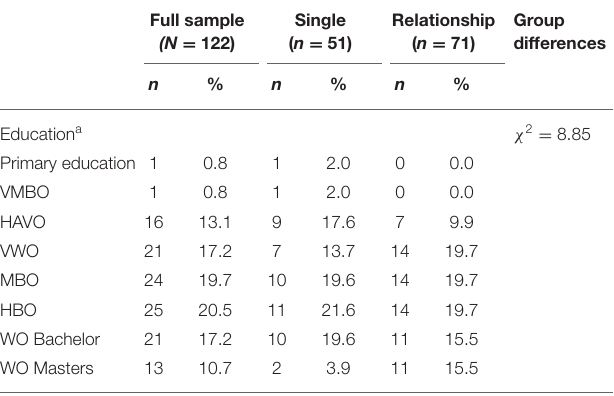
TABLE 1 | Education level in Study 1 (Pilot